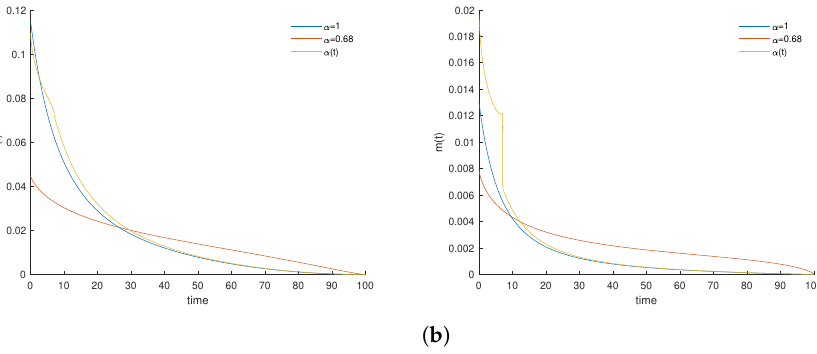
Figure 10. Comparison of variables v and m of the FractInt system with the ones of the FOCP (8)–(13) with α = 1 and α = 0.68, considering the parameter values from Table 1. ( a ) Contour of vaccination, v ; ( b ) Evolution of the hygiene control, m